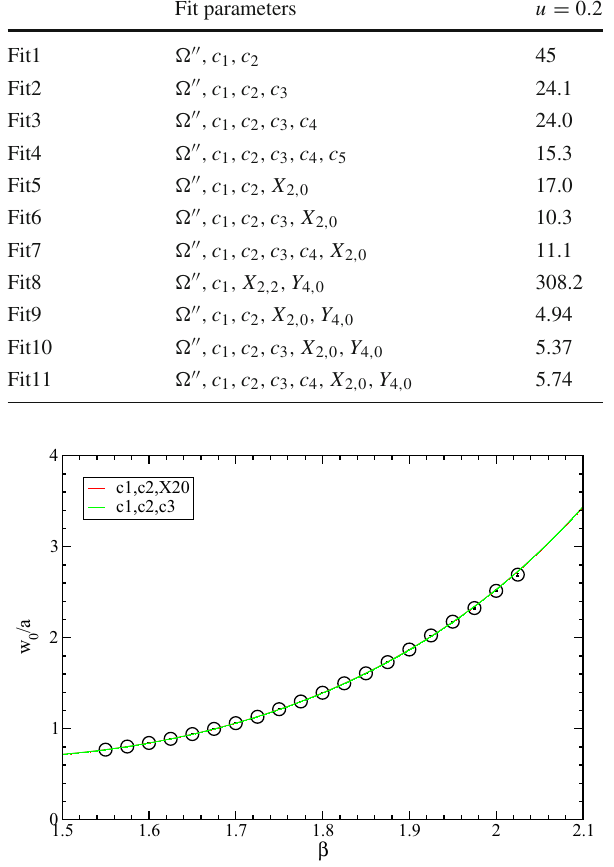
Fig. 5 Plot d β/ d ( log ( a ))